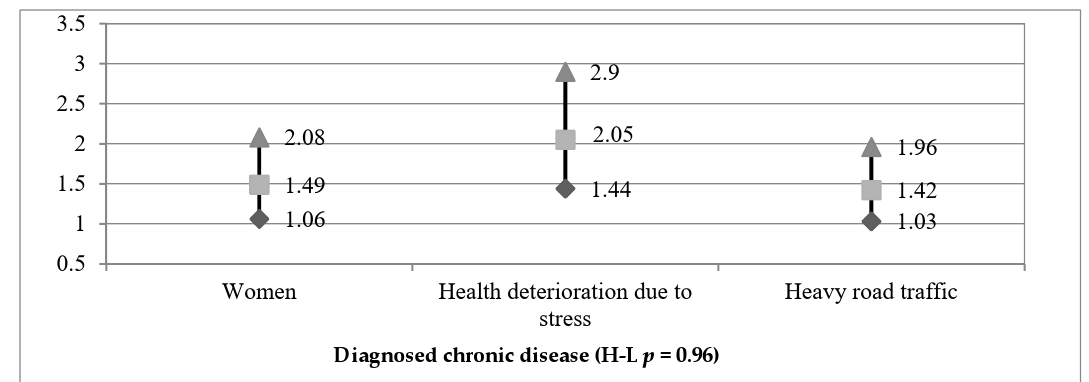
Figure 2. Odds ratio and 95% confidence interval for diagnosed chronic disease and particular independent variables ( N = 905).